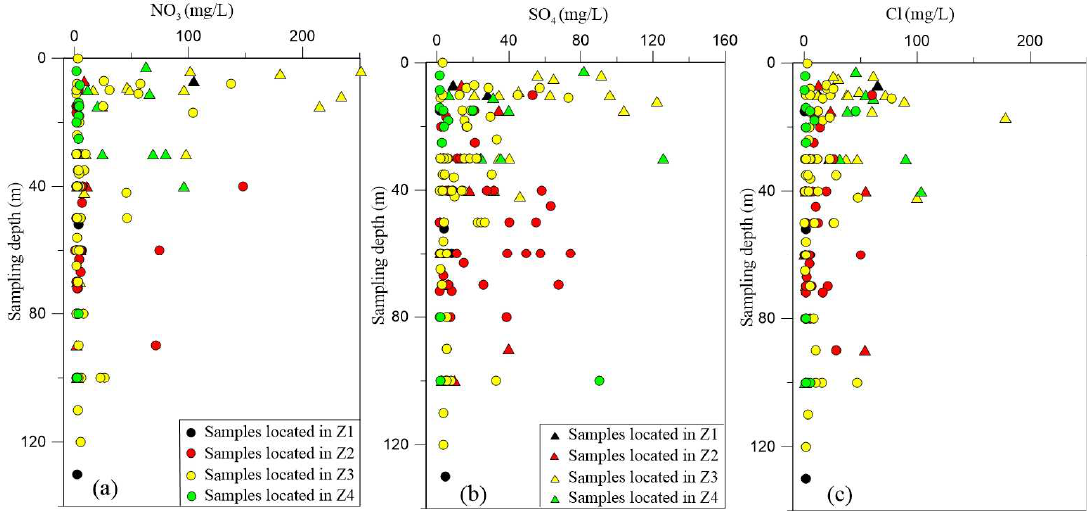
Figure 10. Variations of ( a ) NO 3 , ( b ) SO 42− , ( c ) Cl with sampling depth (well depth).